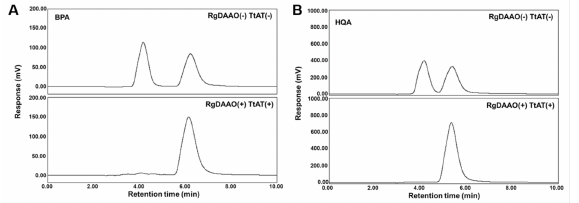
Figure 4. Chiral HPLC analyses of coupled-enzymatic reactions for racemic BPA ( A ) and HQA ( B ). Conditions: 50 mM HEPES-NaOH (pH 8.0), 0.1 M KCl, 1.0 mg/mL catalase, 5 mM UAA, and 5 µ M of RgDAAO and TtAT. The reaction mixture was incubated at 25 ◦ C for 30 min. The reaction was quenched by adding methanol. The supernatant obtained after centrifugation was analyzed by